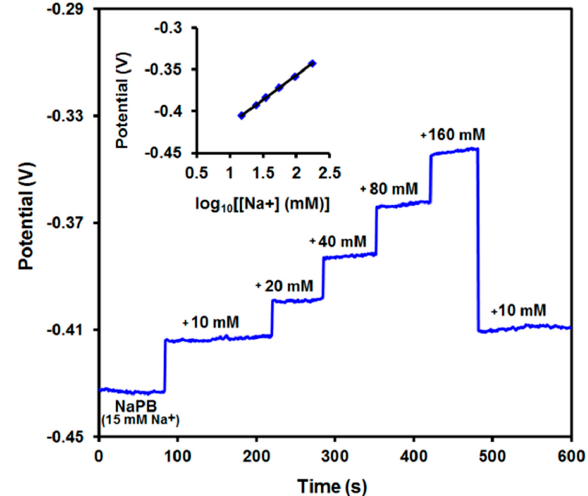
layer significantly enhanced the potential stability; ( c ) Potential stability test for SPE/ChPBN/Na + ISE showing ten consecutive measurements for two hours. Inset: calculated potential drift for every 2 h as a function of time.